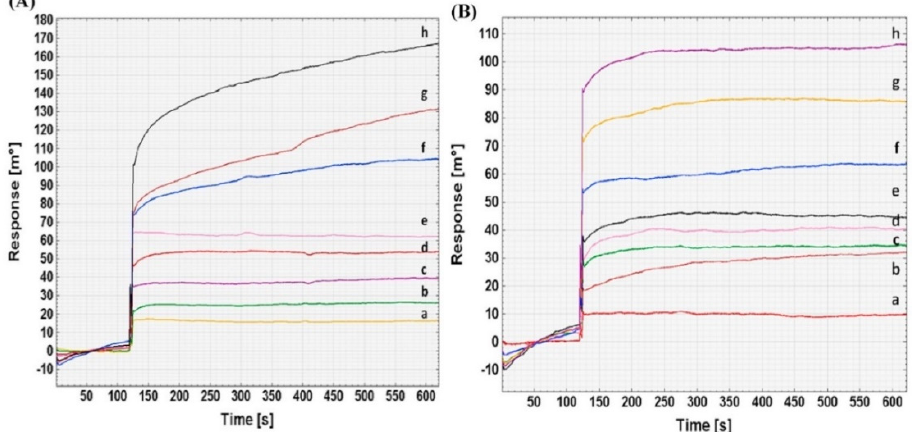
Figure 3. Surface plasmon resonance (SPR) sensor responses for di ff erent dilutions’ (1:12,800 (a), 1:6400